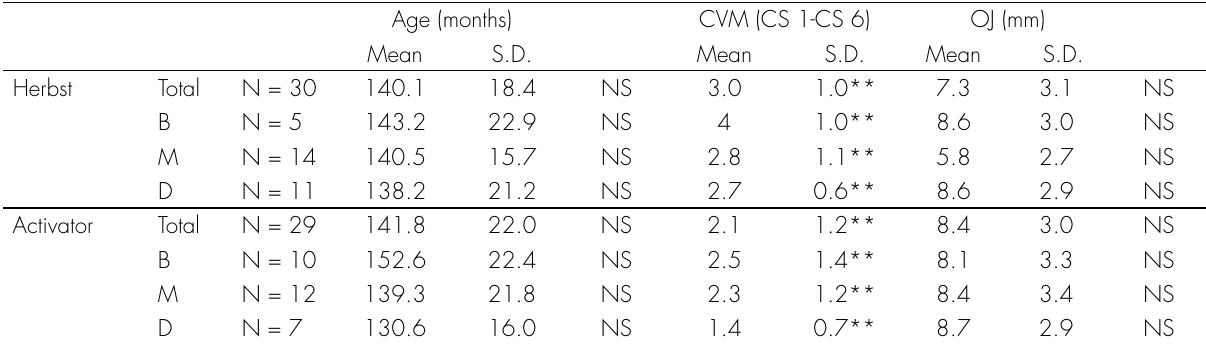
Table I. Pretreatment